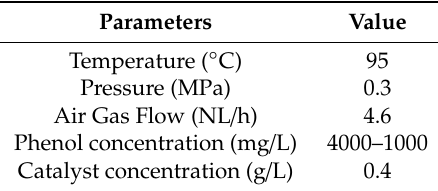
Table 1. Operating conditions.